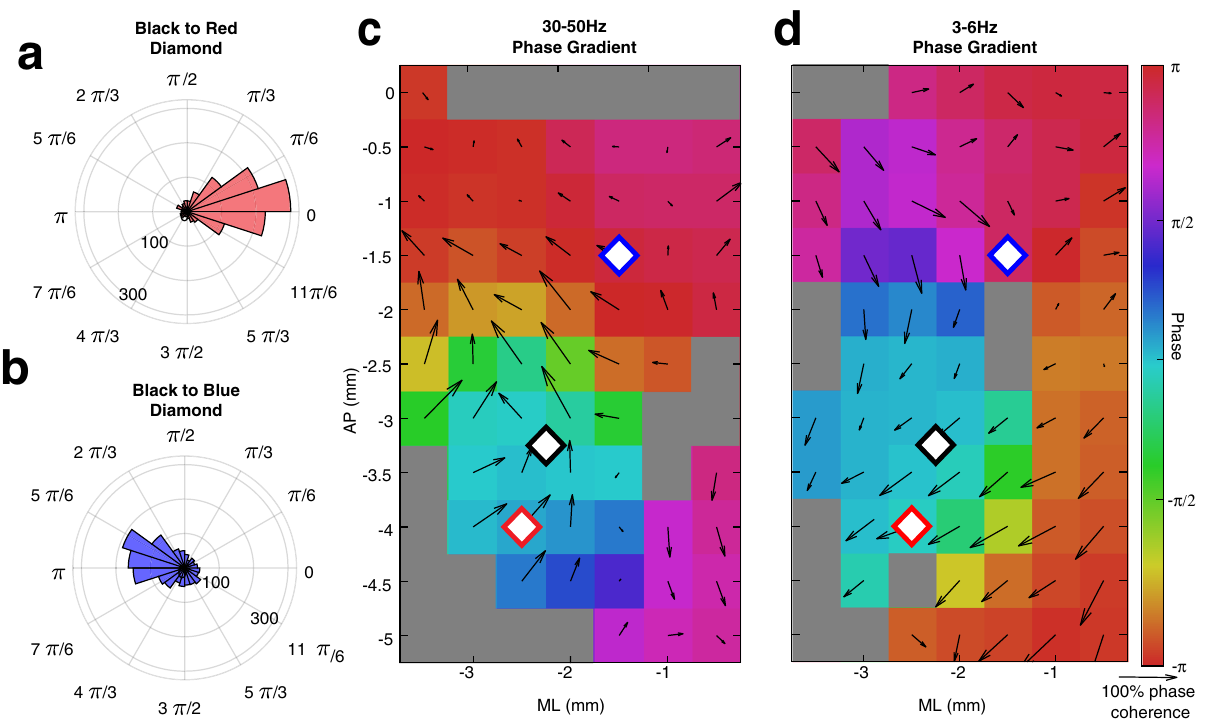
Fig. 3 | SVD identi fi es visual-evoked traveling waves that are consistently eli- citedbothacross trials andacrossanimals.a Histogram of the difference in the spatial phase of the most visually responsive 30 – 50Hz mode between two elec- trodes in V1 (black and red diamonds in c ) across trials and animals. b Histogram of phase angle difference of the most visually responsive 30 – 50Hz mode between an electrode in V1 (black diamond in plot c ) and PPA (blue diamond in plot c ) across trials andanimals. Note thatthephase angle differenceisincreased as distance from V1 increases. c At each stereotaxic location, the average phase offset of the 30 – 50Hz spatial mode relative to V1 (the black diamond) is plotted